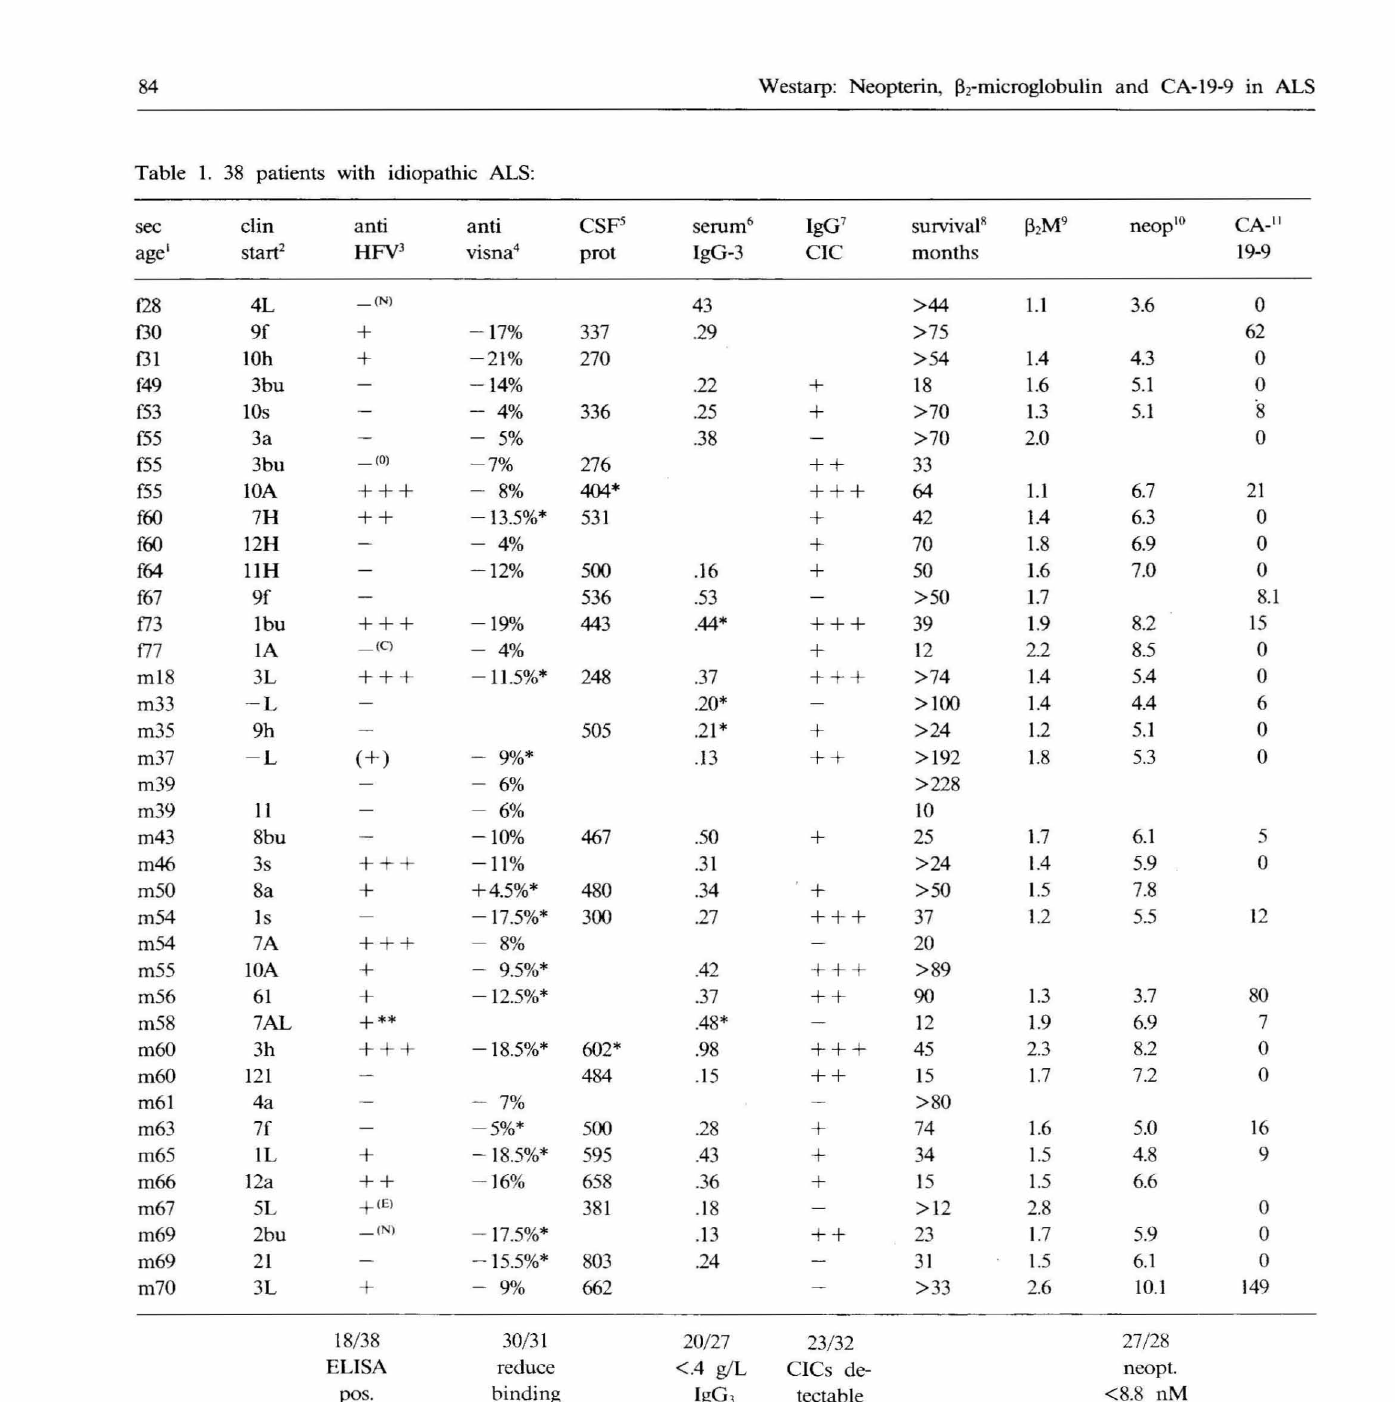
Table 1. 38 patients with idiopathic